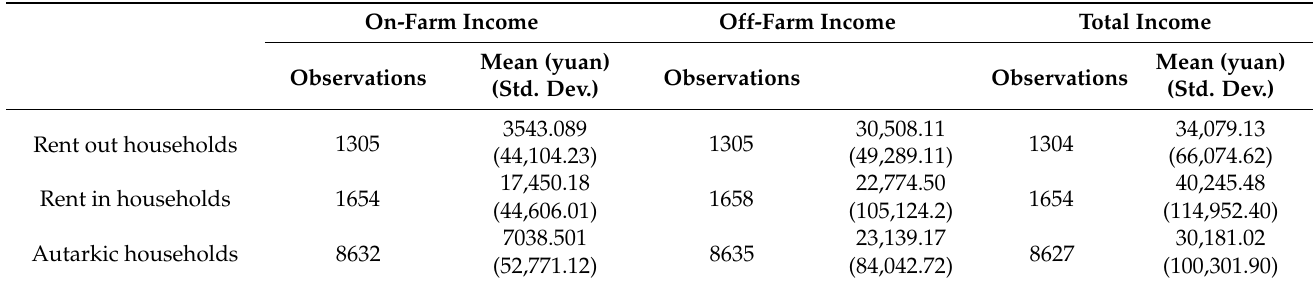
Table 2. The income differences among households.